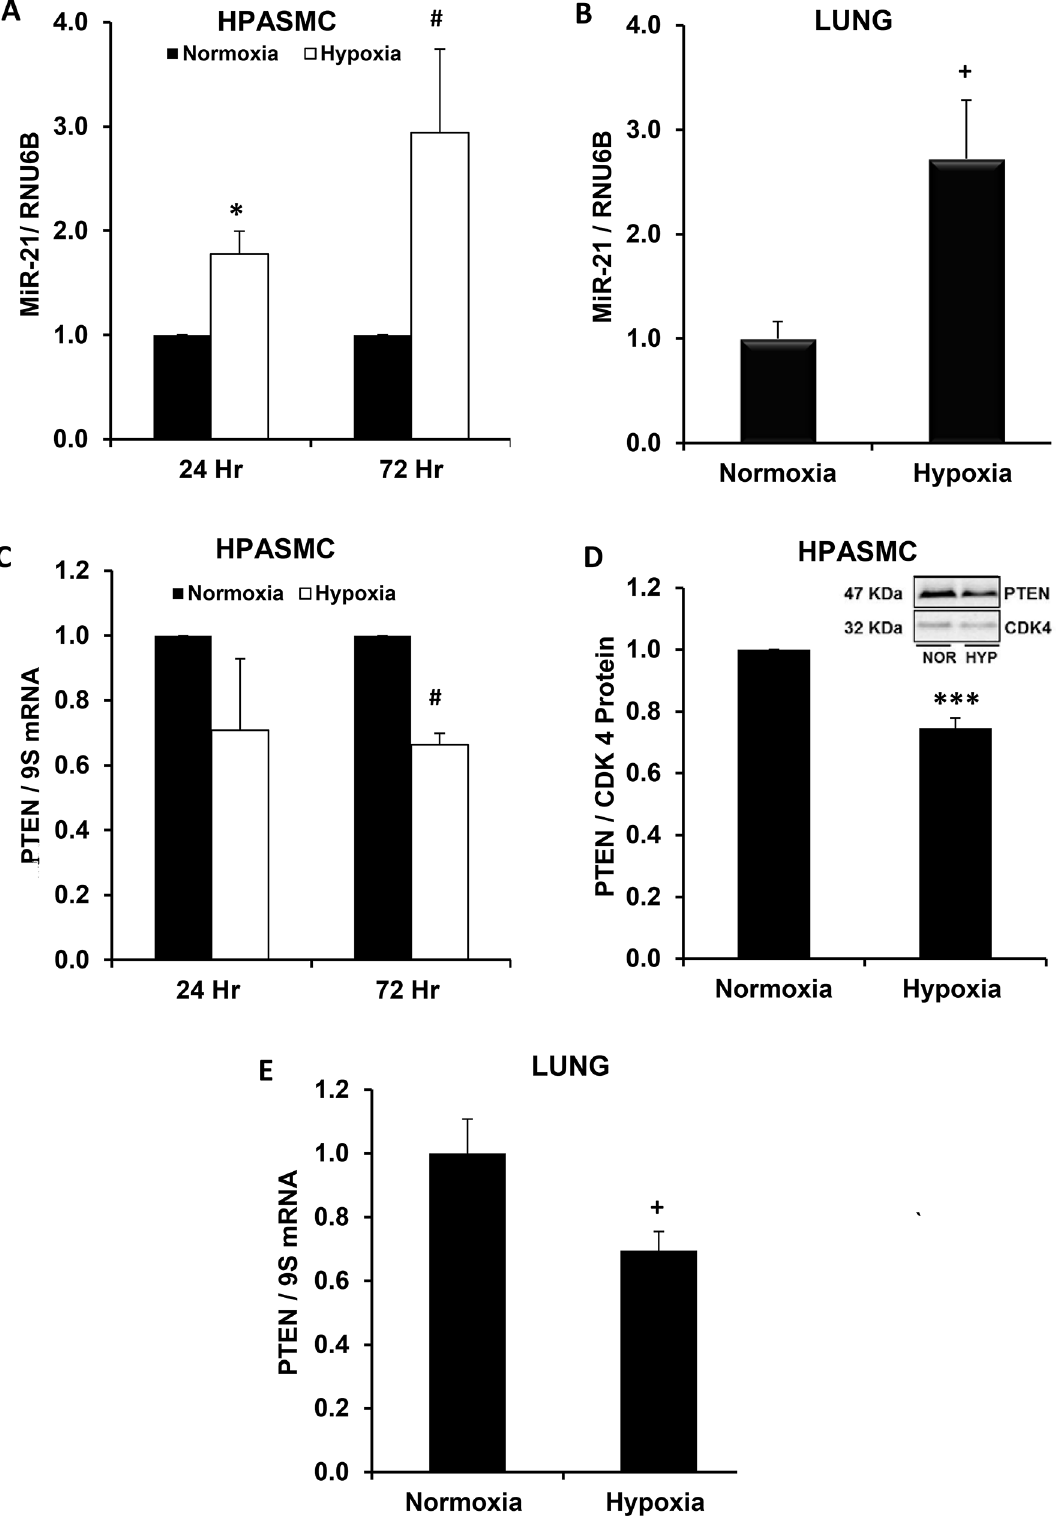
Fig 2. Hypoxia increases miR-21 and reduces PTEN levels in HPASMC in vitro and in the mouse lung in vivo. HPASMC were exposed to normoxic or hypoxic conditions for 24 – 72 hours (A,C,D) and mice were exposed to normoxia (21% O 2 ) or hypoxia (10% O 2 ) for 3 weeks (B,E). Large and small mRNA